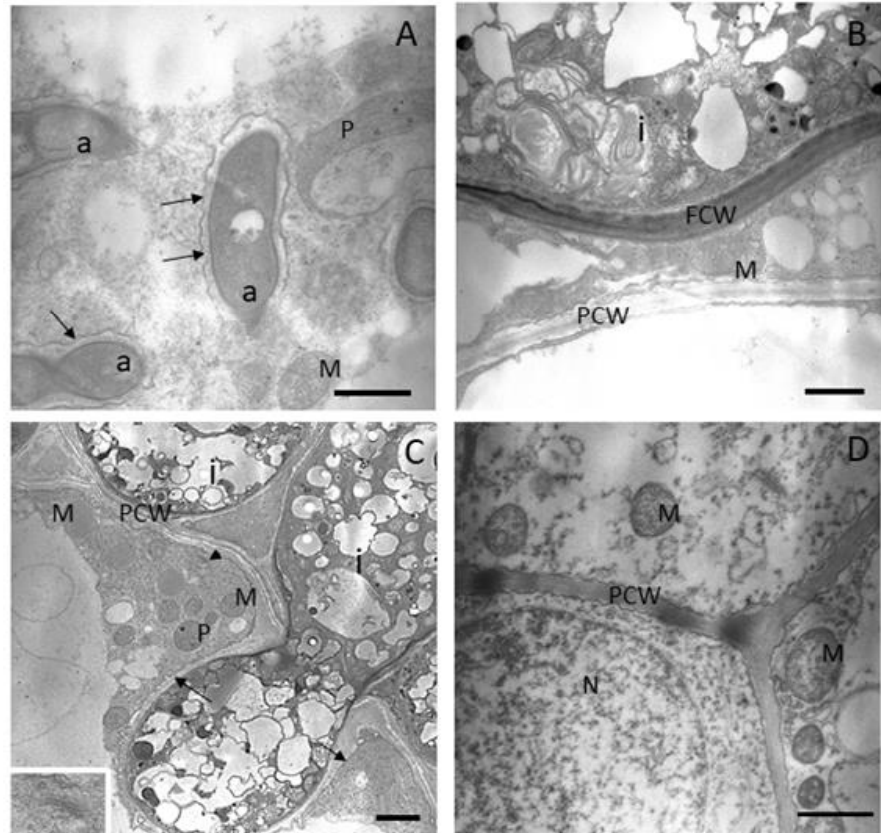
Figure 2. Transmission electron microscopy images of thin sections of saffron roots colonised by Rhizophagus intraradices and Funneliformis mosseae (Ri + Fm, A ), R. intraradices alone (Ri, B and C ) or the control (AMF-, D ). In details, a: fungal arbuscule; N: nucleus; M: mithocondria; P: plastids; i: fungal hyphae; PCW: plant cell wall; FCW: fungal cell wall; arrow: plant plasmamembrane; arrowhead and inset: Golgi apparatus. The bar is 1 μ m in A, B, C and D.